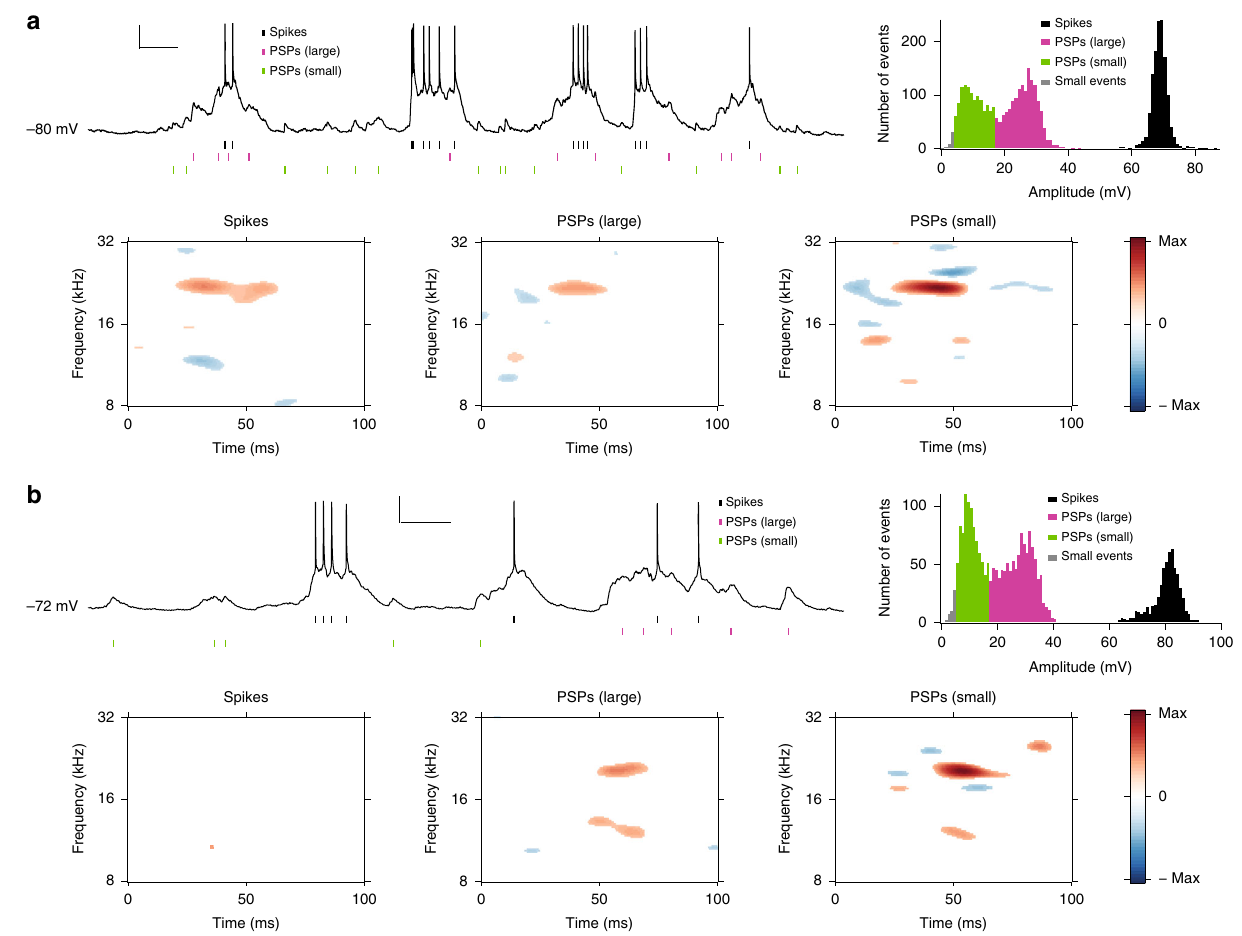
Fig. 2 Spectrotemporal receptive fi elds obtained from in vivo current-clamp whole-cell recordings to the DMR stimulus. a Top left, a segment of a neuron response to the DMR stimulus. The short black line marks indicate spike times. Horizontal scale: 0.3 s; vertical scale: 15 mV. The magenta and green marks indicate peak times of PSPs with large and small amplitudes, respectively. Top right, an amplitude histogram of spikes and PSPs was obtained from the left recording and shows a bimodal PSP peak amplitude distribution. Bottom, the spike STRF ( fi rst), the STRF for large PSPs (second), and the STRF for small PSPs (third) resulted from spike times (black in the histogram), peak times of large PSPs (magenta in the histogram), and peak times of small PSPs (green in the histogram), respectively. The number of peaks included in computing each STRF was 1226 for spikes, 1437 for large PSPs, and 1162 for small PSPs. Bottom right, the color bar goes from the overall maximum (red) to the minus maximum (blue) on the same absolute scale of three STRFs from spikes, large PSPs, and small PSPs. b As in ( a ), but from a different neuron. Top left, horizontal scale: 0.3 s; vertical scale: 20 mV. Top right, an amplitude histogram shows a bimodal PSP peak amplitude distribution. The number of peaks included in computing each STRF (bottom) was 532 for spikes, 1009 for large PSPs, and 863 for small